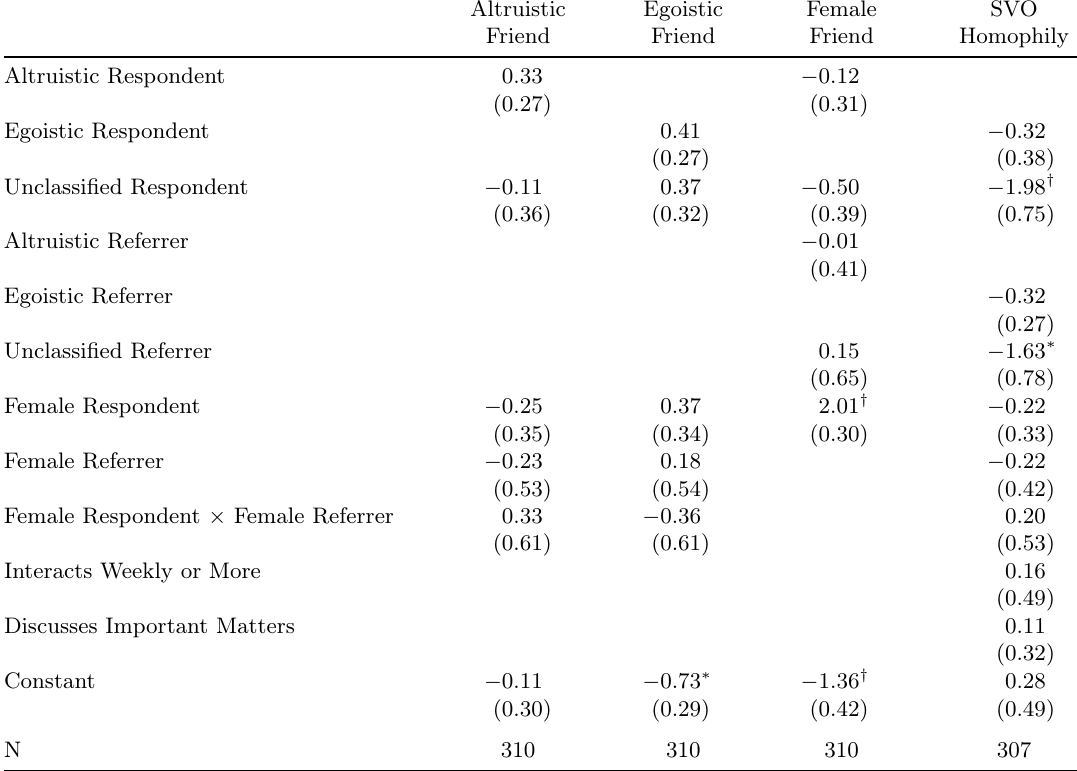
Table 1: Logistic Regression Estimates for Models Predicting Altruism Homophily in a Respondent Driven Sample (Study